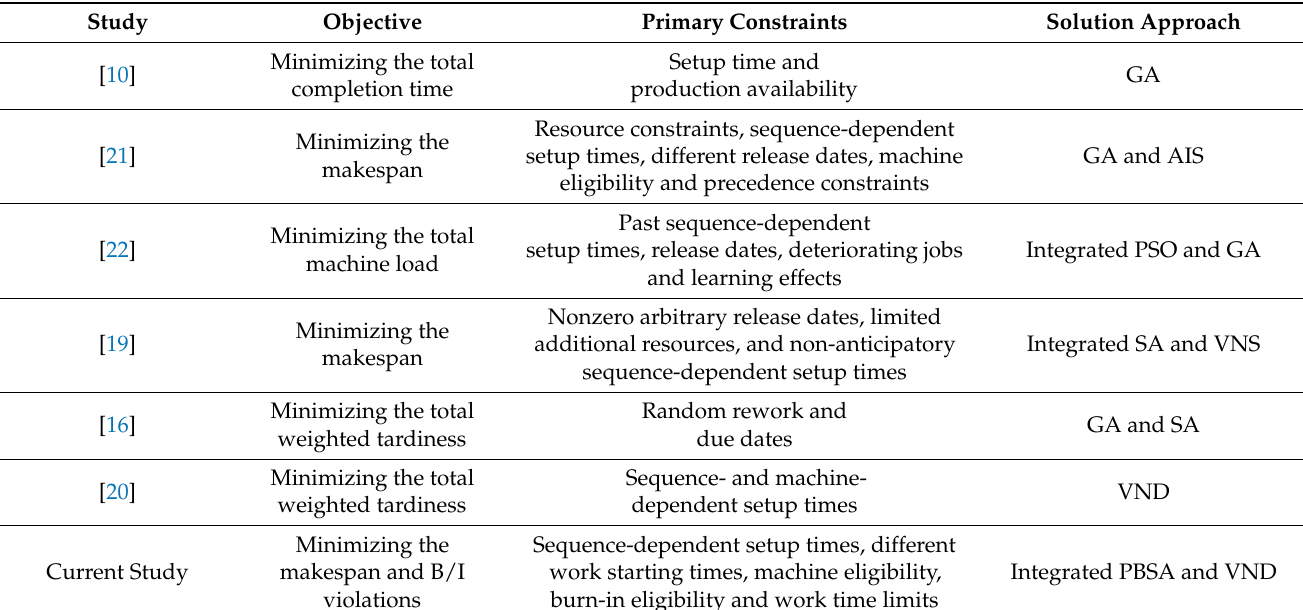
Table 1. Literature comparison.